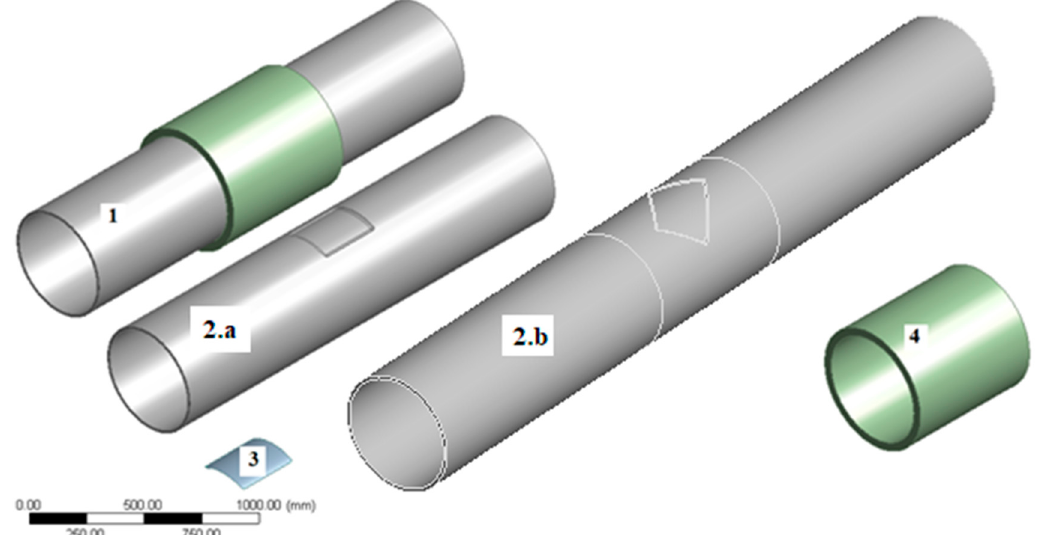
Figure 5. FEA general model: 1—steel pipe repaired with a composite system; 2.a—pipe (2 m long) with a straight local metal loss defect ( α = 0 deg); 2.b—pipe (3 m long) with an inclined metal loss defect ( α = 45 deg); 3—filler (to ensure the load transfer); 4—composite material wrap.